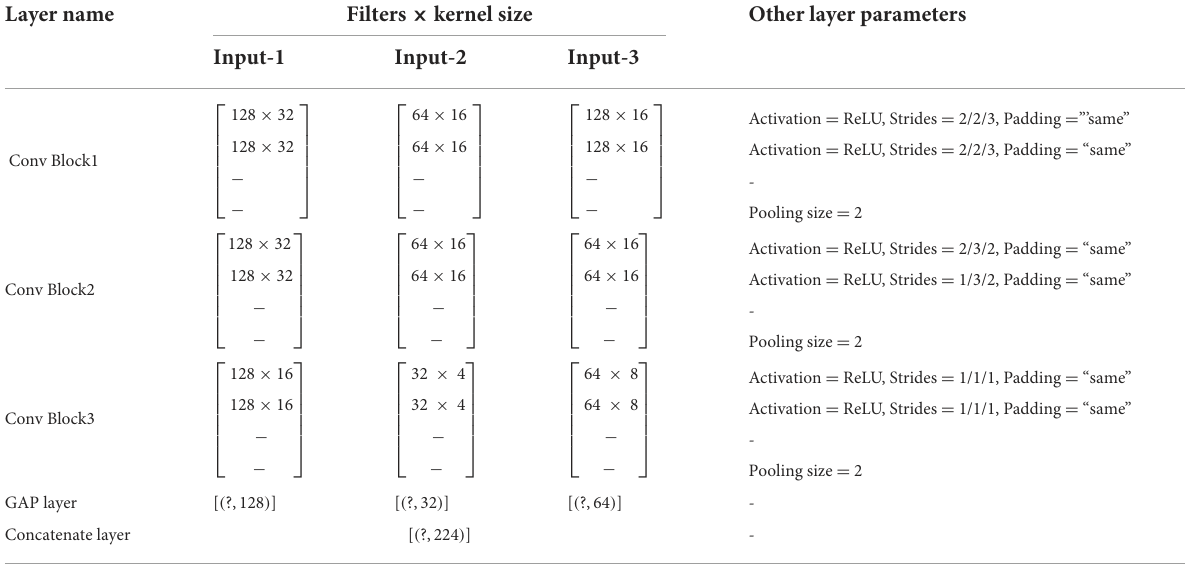
TABLE 4 Detailed feature extraction structure of the multi-input deep convolutional neural